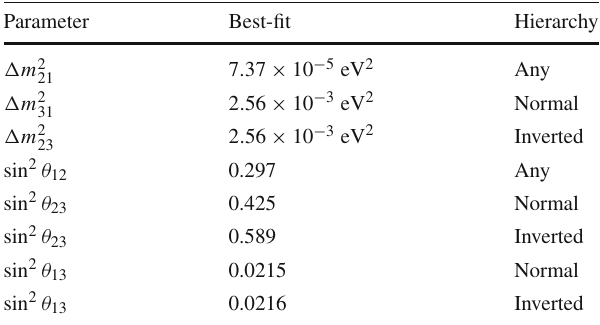
Parameter Best-fit